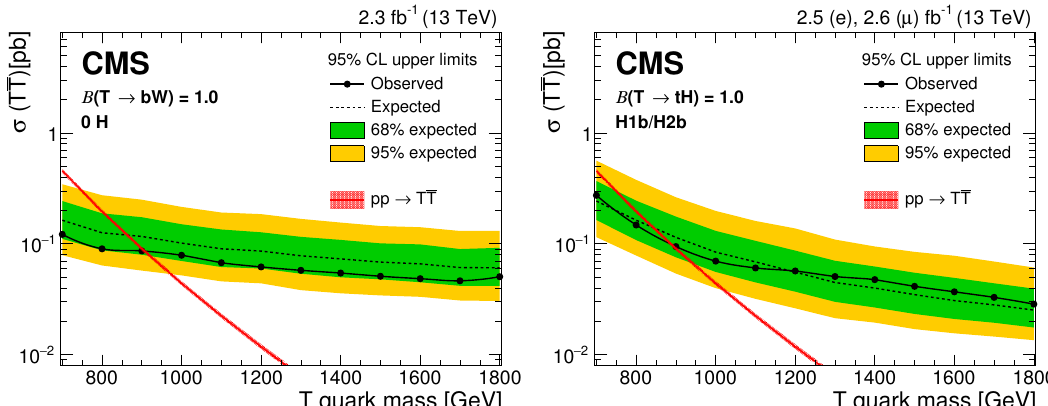
Figure 11 . The expected and observed upper limits (Bayesian) at 95% CL on the cross section of TT production for 100% T ! bW in the boosted W channel (left), and 100% T ! tH in the boosted H channel (right). The theoretically predicted cross section for TT production calculated at NNLO is shown as red line, with the uncertainties in the PDFs and renormalization and factorization scales indicated by the shaded area. Masses below 700 GeV were excluded previously.